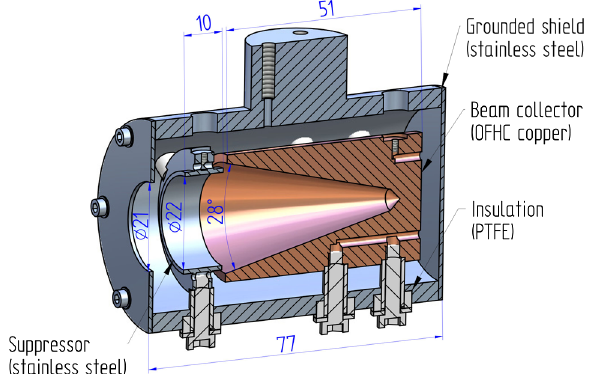
FIG. 16. Cross-section view of the Faraday cup